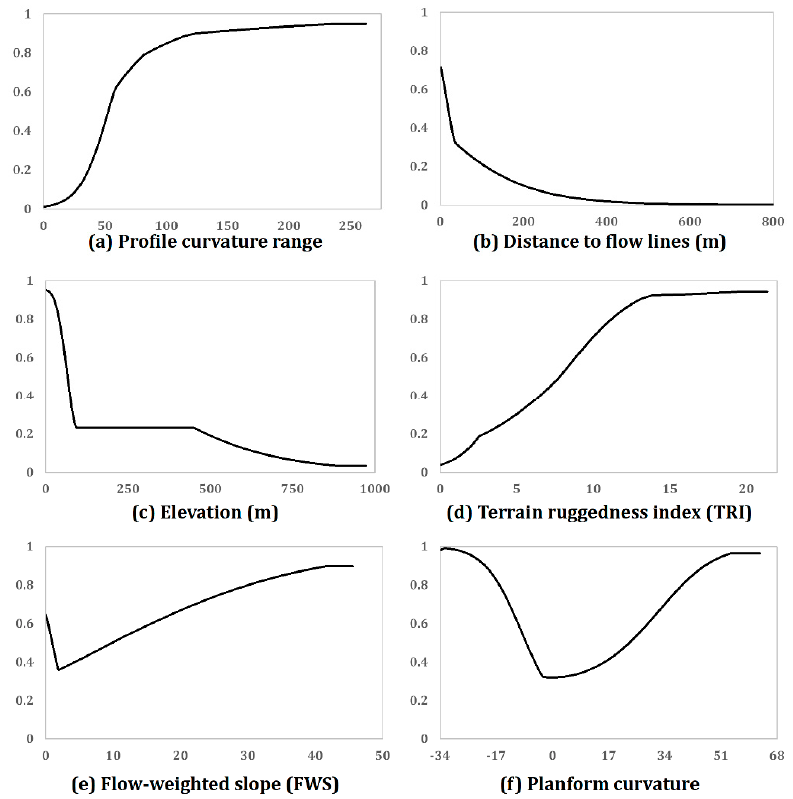
Figure 6. Predicted probability of prevalence ( y -axis) for six topographic variables used in the final Maxent model to predict seeps and springs: ( a ) profile curvature range, ( b ) distance to flowlines, ( c ) elevation, ( d ) TRI, ( e ) FWS, and ( f ) planform curvature. The curves represent the dependence of predicted prevalence on both the individual topographic variables and the correlations between them. Table 2. Permutation importance for variables used to predict seeps and springs using the Maxent model.